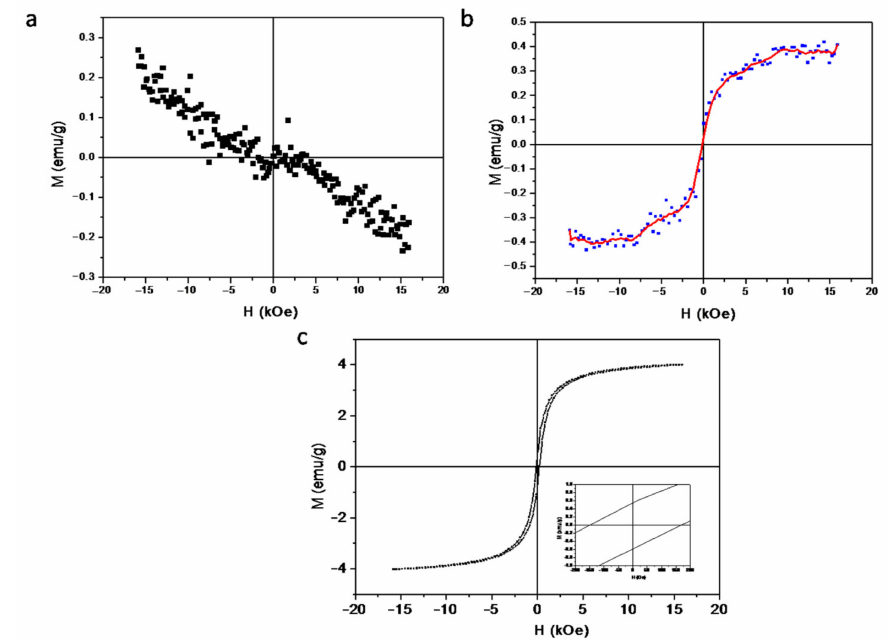
Figure 2. Magnetic properties of ferroarabinogalactan. ( a ) Pure arabinogalactan does not have a magneticmoment. ( b